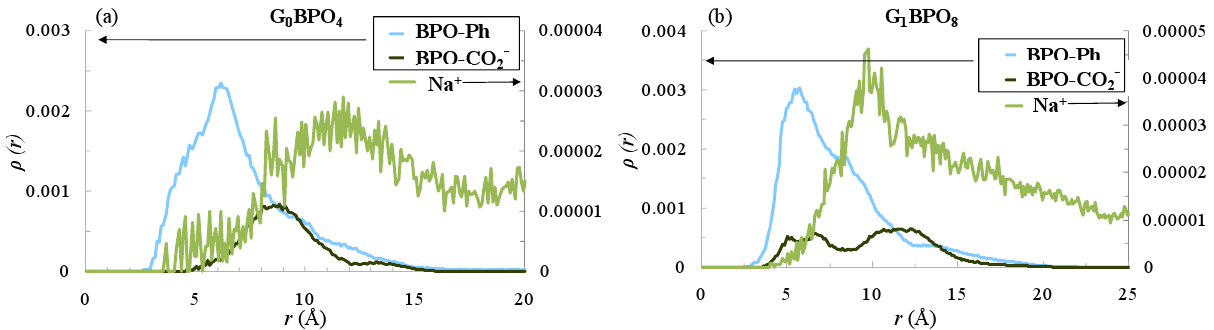
The benzylpenicilloyl residues could be considered as negative charged thiazolidine rings − ) plus the rest of the benzylpenicilloyl fragments (BPO-Ph). Figure 13 shows the radial (BPO-CO 2 density profiles of these subunits for all the dendrimers. In all of the dendrimers, the apolar subunit (BPO-Ph) is always oriented toward the core of the dendrimers whereas the polar BPO-CO oriented toward the exterior. In higher generations this subunit shows a plateau at the periphery, suggesting a more uniform distribution on the outside of the molecule. Figure 13. Density distributions of thiazolidine rings (BPO-CO benzylpenicilloyl fragments (BPO-Ph) of BPO, and the distribution of the sodium ions with respect to the center-of-mass of the dendrimer for all the examined